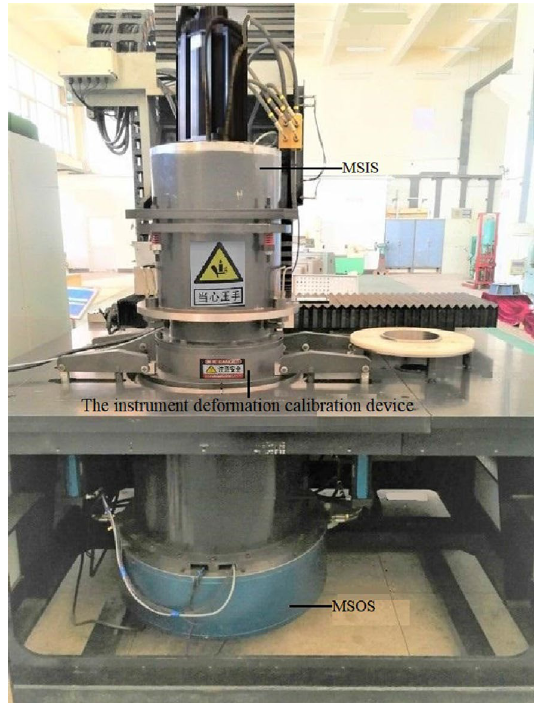
Figure 10. Calibration experiment of the angle measurement error caused by the deformation of the